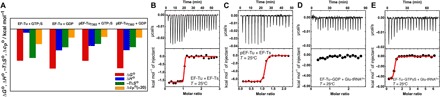
Thermodynamics of the interaction between EF-Tu and pEF-TuT382 with nucleotides, EF-Ts and Glu-tRNAGlu.(A) Thermodynamic fingerprint of the interaction between EF-Tu and pEF-TuT382 with nucleotides. The themodynamic parameters (ΔG, ΔH, −TΔS, and ΔcP) that describe the interaction of EF-Tu with GDP and GTPγS are compared to those for the interaction of pEF-TuT382 with GDP and GTPγS in the bar plot. ITC titration of EF-Ts into EF-Tu (B) and pEF-TuT382 (C) at 25°C. ITC titration of pEF-TuT382 into Glu-tRNAGlu (D) and EF-Tu into Glu-tRNAGlu (E) at 25°C.